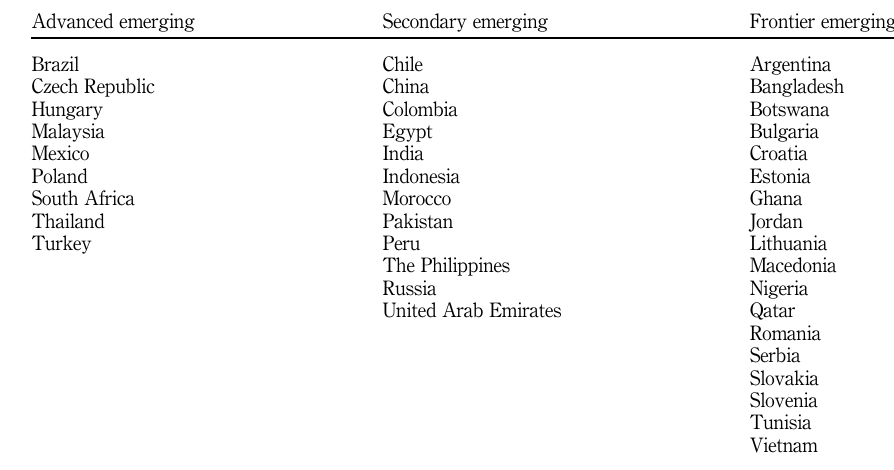
Table I. Sampled emerging